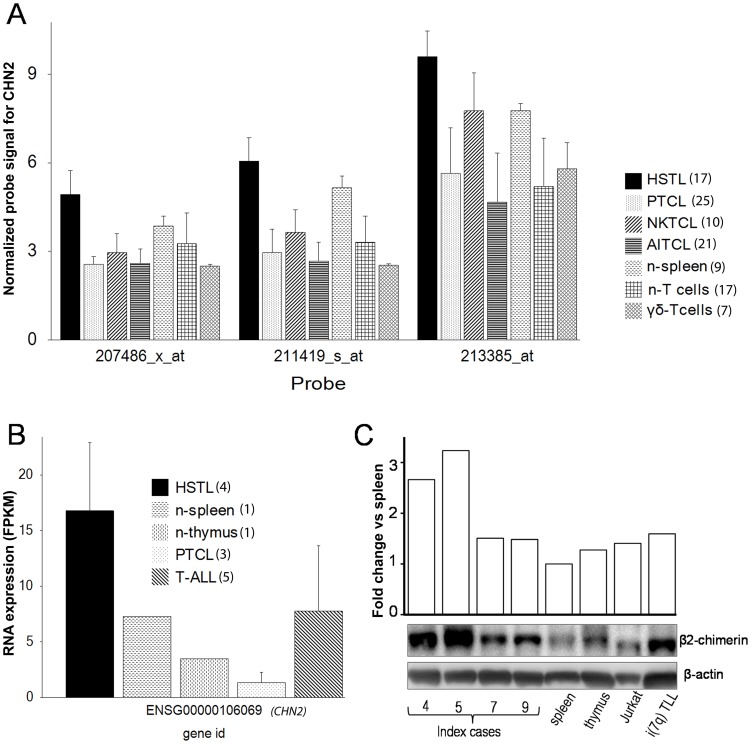
Expression of CHN2/β2-chimerin.A) Normalized values of all CHN2 probes in the used U133 array for the analyzed malignancies and normal controls. The observed expression differences were statistically significant, with FDR_BH <0.05 (Table S6). B) Expression values of CHN2 using the RNAseq data. FPKM (Fragments Per Kilobase of exon Model) is a measurement of transcript abundance in RNAseq experiments. C) Western blotting and densitometry of β2-chimerin. The bars represent the fold change of the normalized intensity of β2-chimerin (compared to β-actin) versus spleen. The number between parenthesis represent the number of samples.